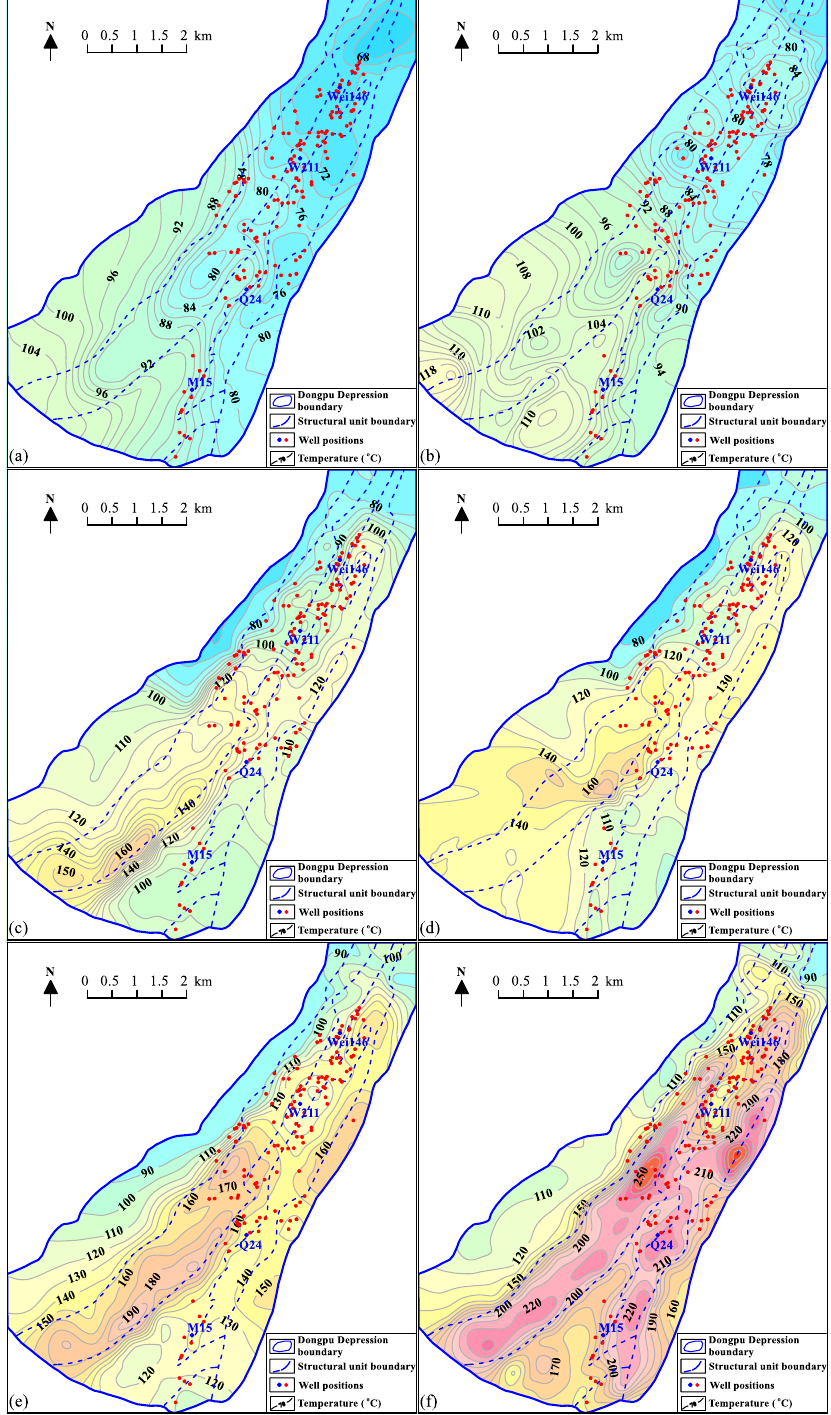
Figure 7. Top surface temperature distribution for the Cenozoic strata in the Dongpu Depression. ( a ) Guantao Formation; ( b ) Dongying Formation; ( c ) Shahejie 1 Formation; ( d ) Shahejie 2 Formation; ( e ) Shahejie 3 Formation; ( f ) Shahejie 4 Formation. Figures were produced by Surfer 15 (https:// www. golde nsoft ware. com/ produ cts/ surfer/) and BasinView 2012 (https:// www. platte. com/ softw are/ basin